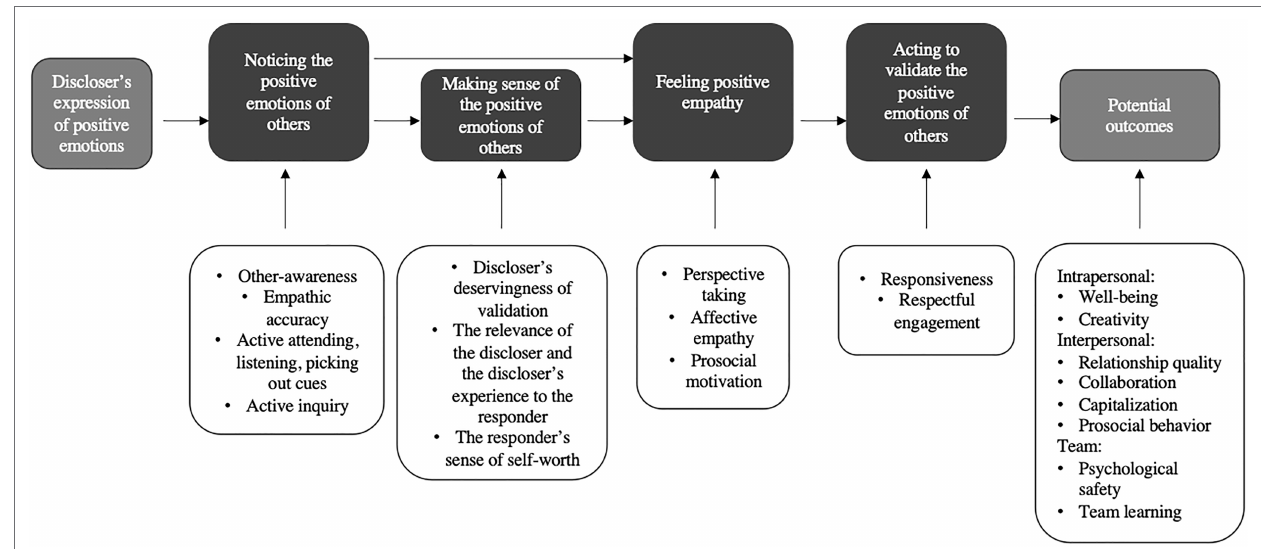
FIGURE 1 | The process of responding to validate the positive emotions of coworkers (partially adapted from Dutton et al.,